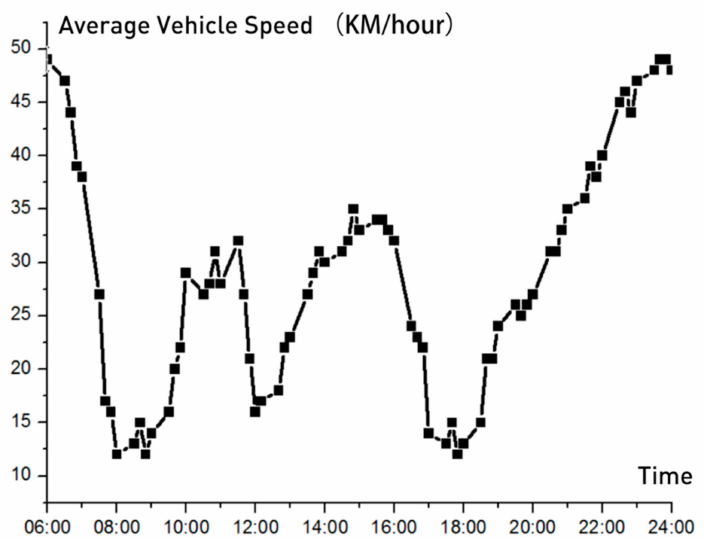
Figure 4. Road vehicle average speed.